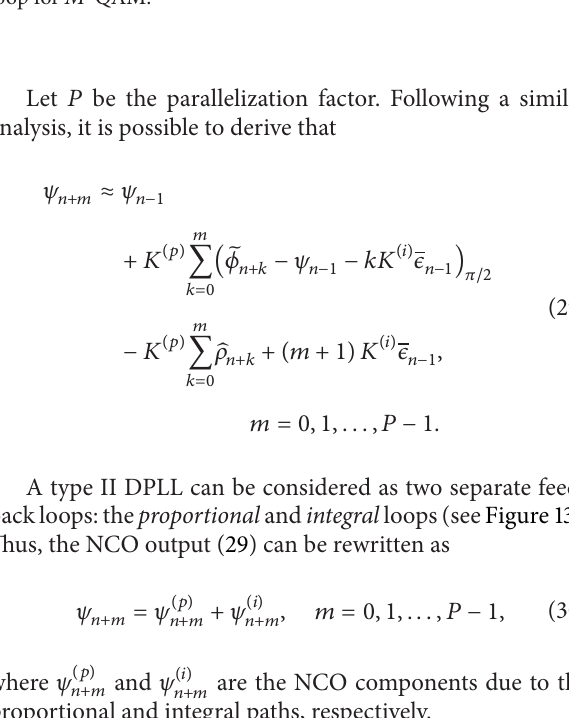
Figure 14: Implementation of the low latency parallel proportional loop for 𝑀